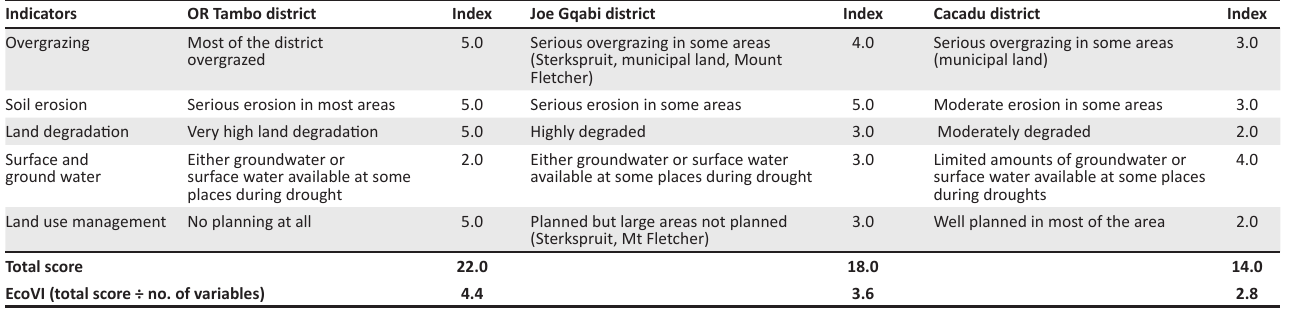
TABLE 3: Estimation of ecological vulnerability indicators.